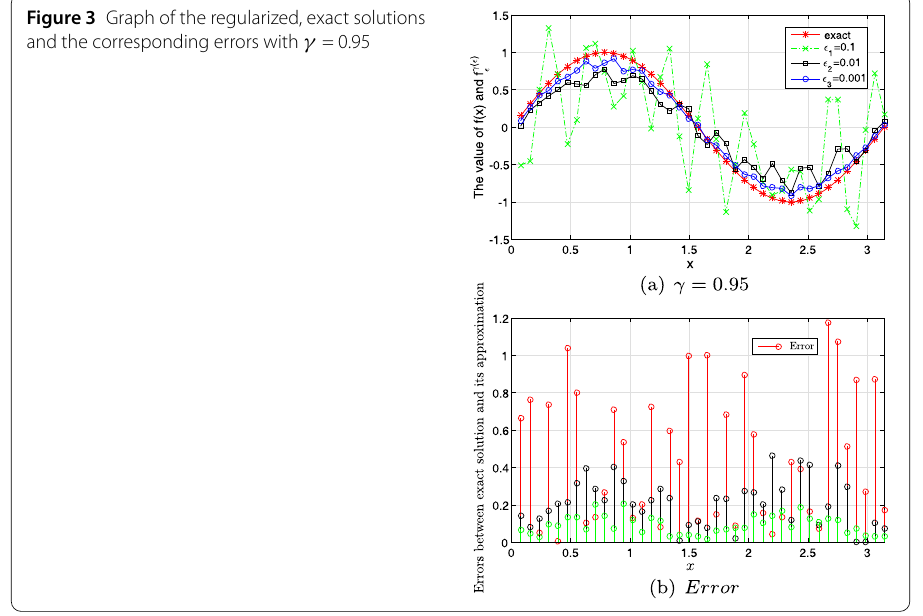
Figure 3 Graph of the regularized, exact solutions and the corresponding errors with γ = 0.95